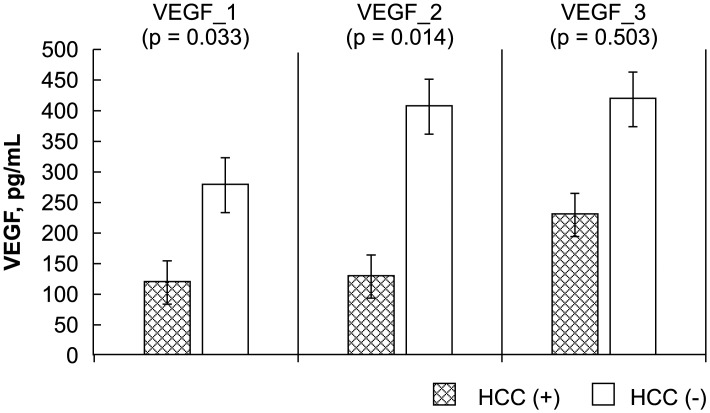
Statistical analysis of FGF-2, survivin, Ki67, endostatin, and VEGF levels, as measured by ELISA before (_1), early after (_2), and late after (_3) after living donor liver transplantation (LDLT).The Mann-Whitney U test was used to compare the differences in the biomarkers at the various time points between the recipients with and those without HCC recurrence.